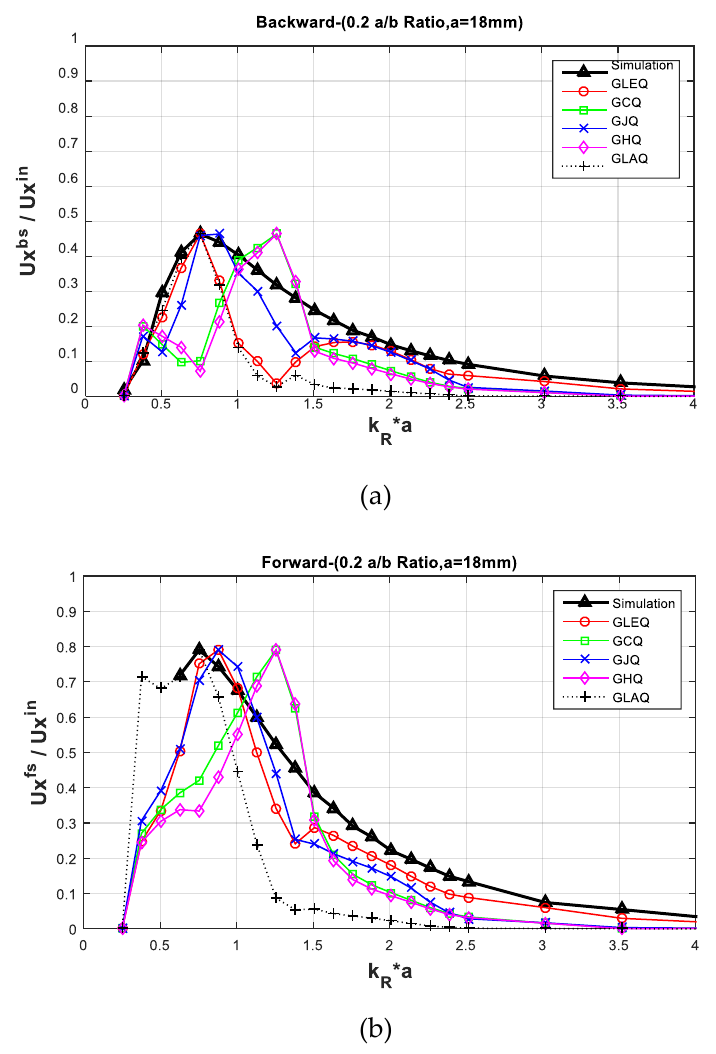
Figure 4. Displacement variation curves from the analytical model and FE simulation by the different direction of the C18–0.2 model: ( a ) backward scattering and ( b ) forward scattering result. The curves show the shape of the displacement variation denoted as u bs / u in and u fs / u in in the analytical model and simulation result. The results indicate that the analytical models solved by different internal methods show a shape similar to that of the FE simulation in both the forward and backward case.